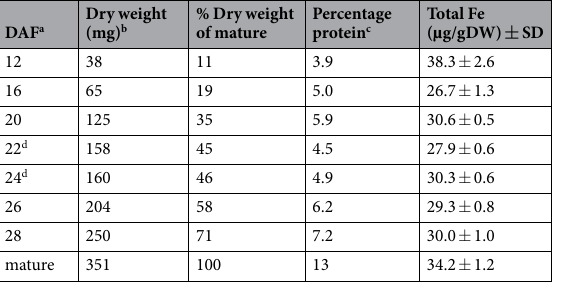
Table 1. Dry weight, protein and iron over the course of development in pea seeds. A typical developmental time course is shown here, a second data set is presented in Figure S2. a Days after flowering. b Average of 3 individual peas which were weighed together. The variance is 10–20%, see Figure S2. c mg protein (relative to of mature peas, corresponding to a tenderometer value of 100, at which stage the seeds are harvested for frozen garden